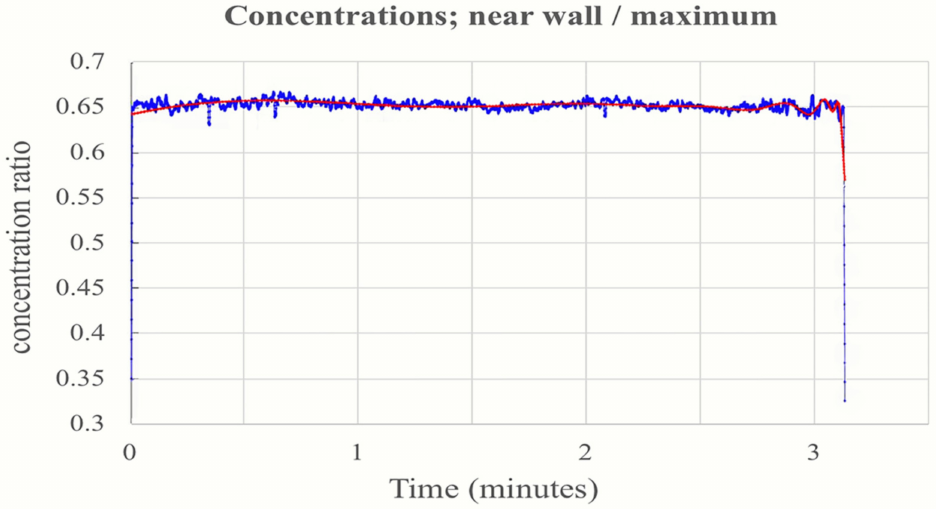
Figure 12. Non dimensional Concentration Rank Factor [k] calculated for the period of silo